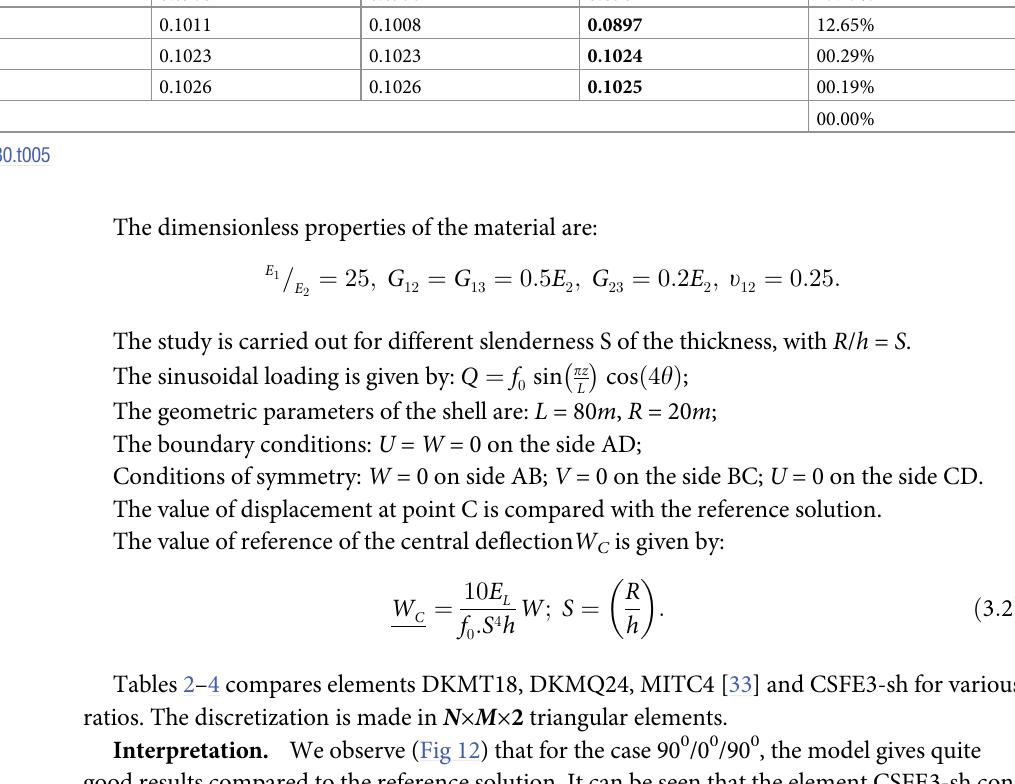
ratios. The discretization is made in N × M × 2 triangular elements.